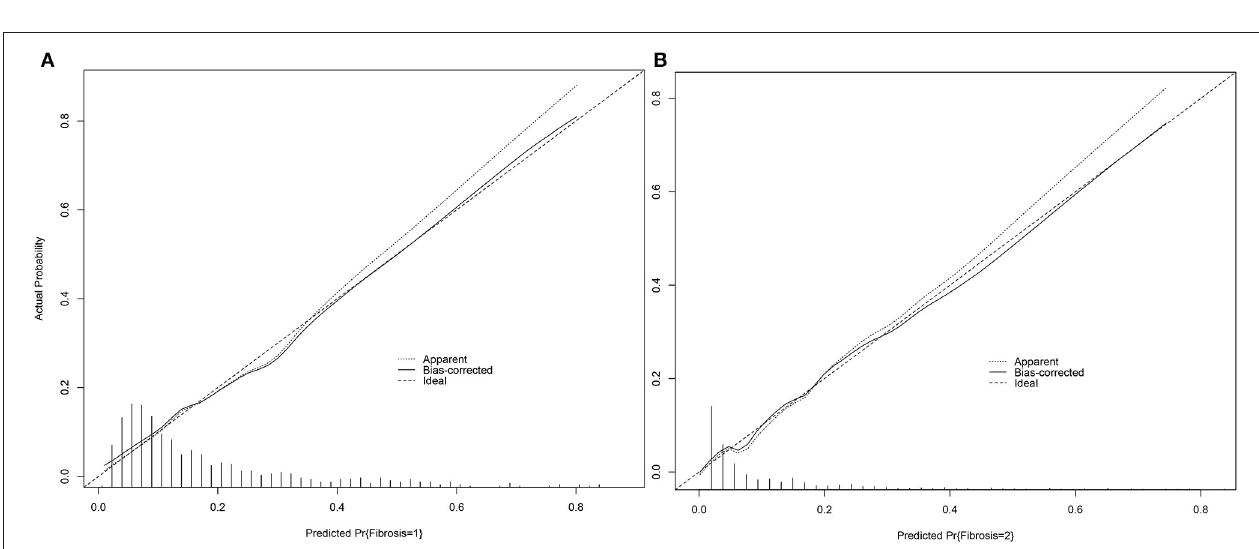
FIGURE 3 | Calibration plot of nomogram for mild-moderate fibrosis (A) and severe fibrosis/cirrhosis (B) .